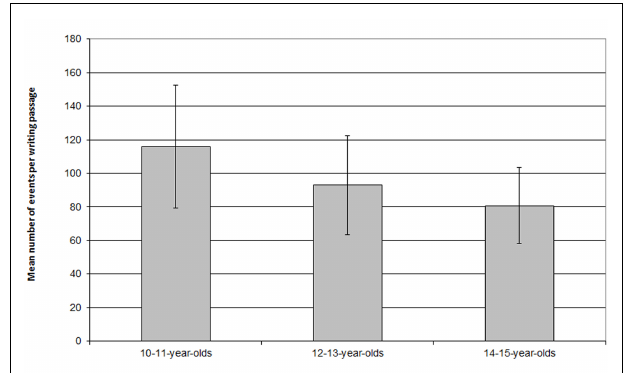
FIGURE 6 | Mean length of writing passages as a function of school level in terms of number of